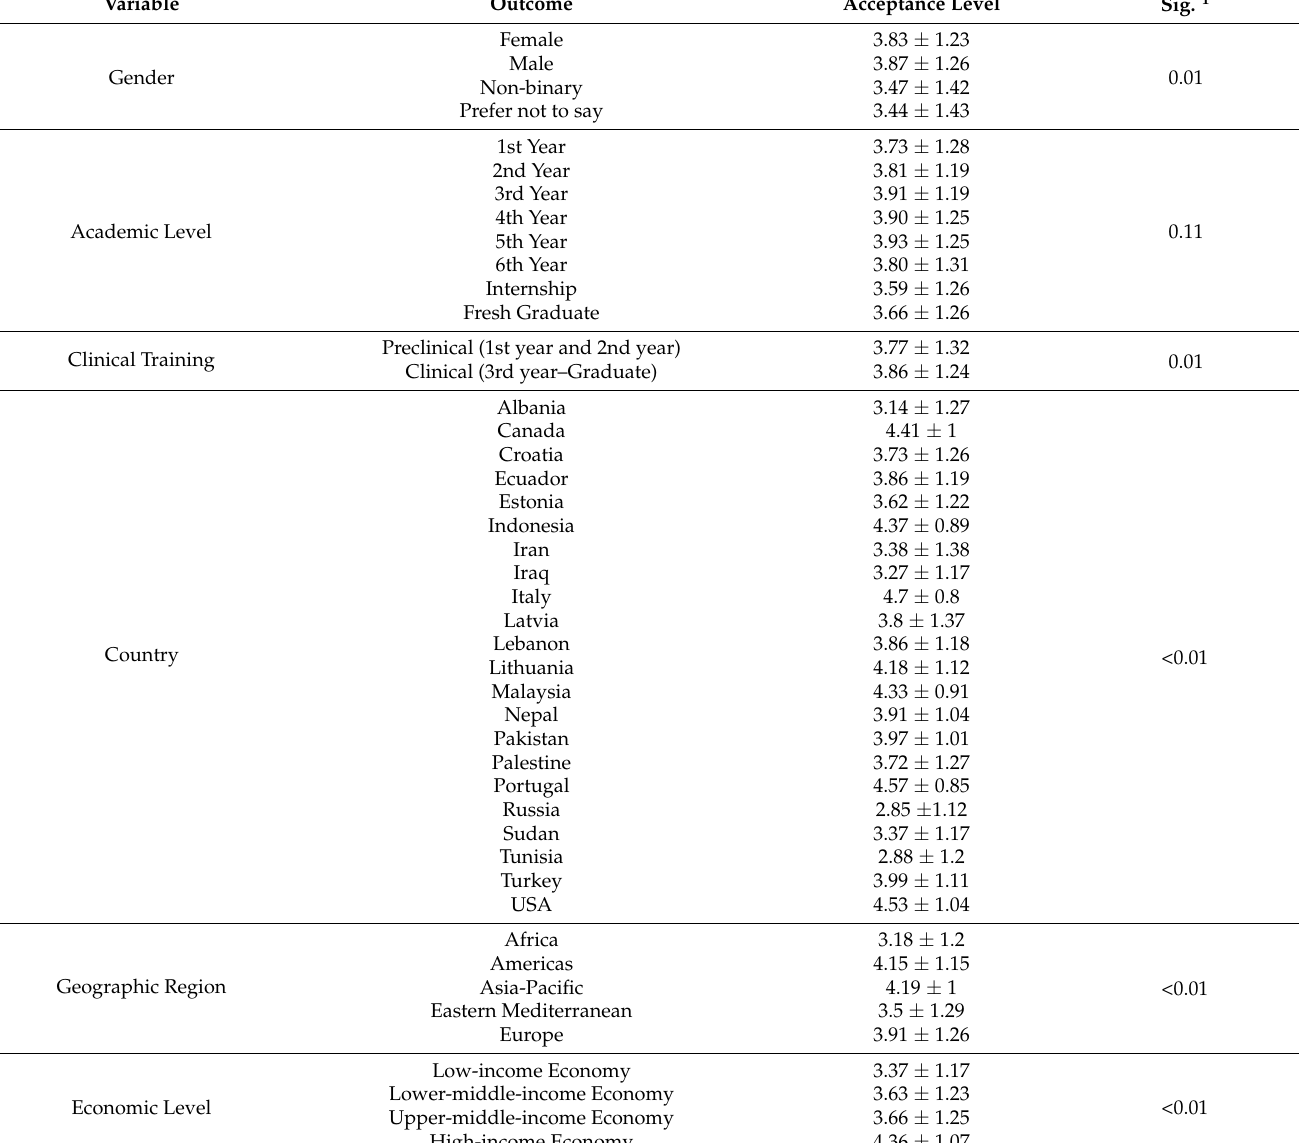
Table 6. Dental students’ demographic determinants of COVID-19 acceptance, February